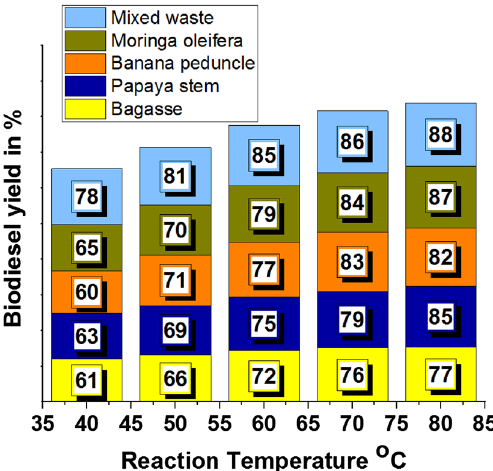
Figure 5. Comparison of biodiesel yield with different plant waste (reaction temperature).